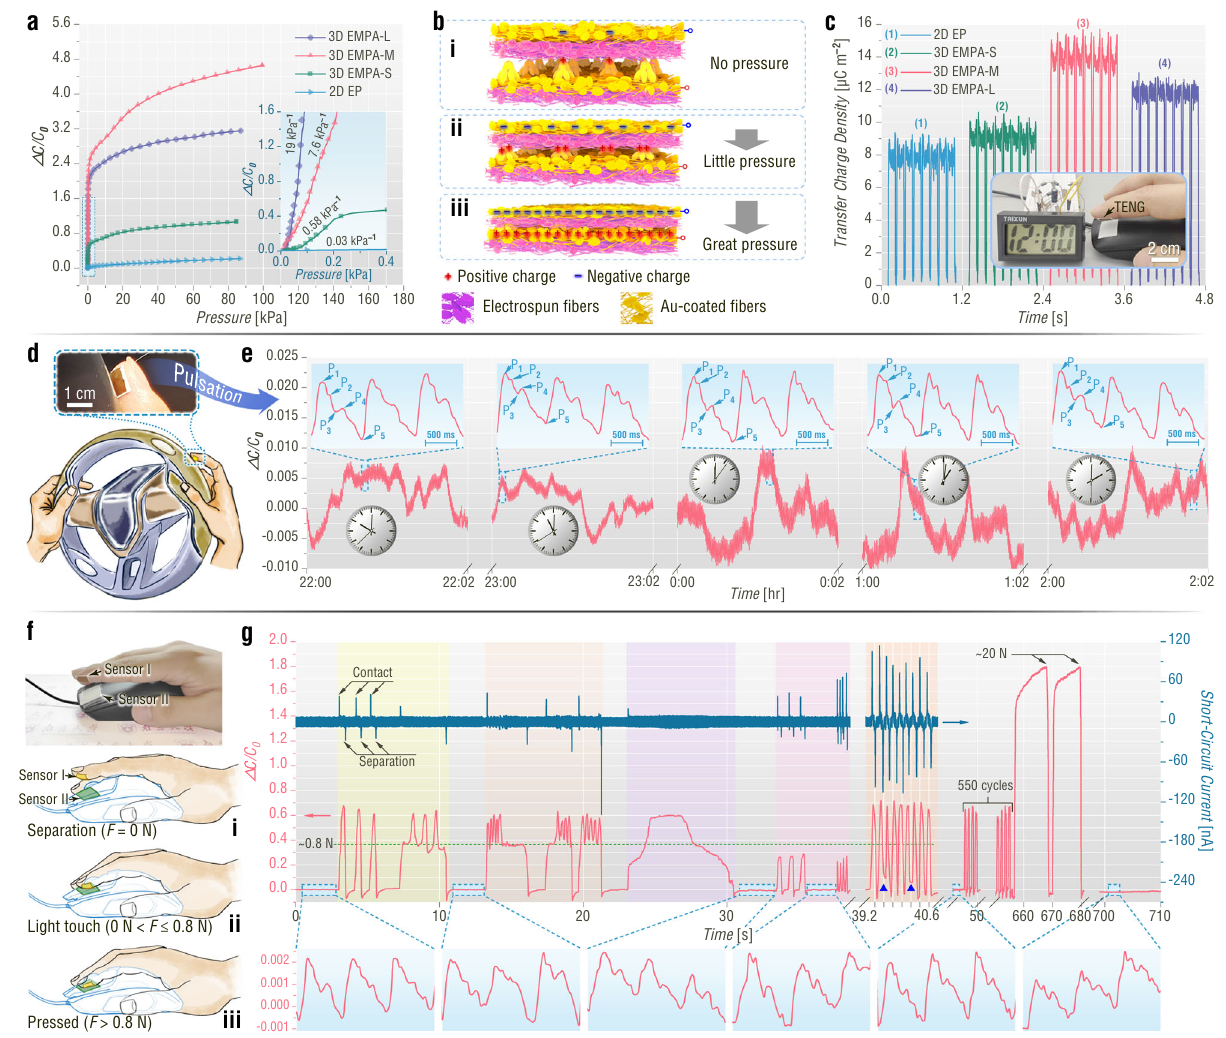
Fig. 5 | Electrical properties and applications of EMPAs in highly sensitive pressure sensing and effective bioenergy harvesting. a Relative capacitance change ( △ C / C 0 ) as a function of pressure applied to electrospun- fi lm-based pie- zocapacitive sensors. The inset presents the pressure range from 0 to 0.4kPa and shows the sensitivities of the sensors. b Schematic illustration of the working mechanism of the EMPA-based piezocapacitive sensor. c Transfer charge densities ofelectrospun- fi lm-basedTENGsunderanimpactforceof5N.Theinsetpresentsa digital clock driven by the 3D EMPA-M-based TENG after clicking a mouse. d – g Superior performance of EMPA-based on-skin devices in health and fi nger manip- ulationmonitoringinnaturalstates. d Picturesshowingthehealthmonitoringfora